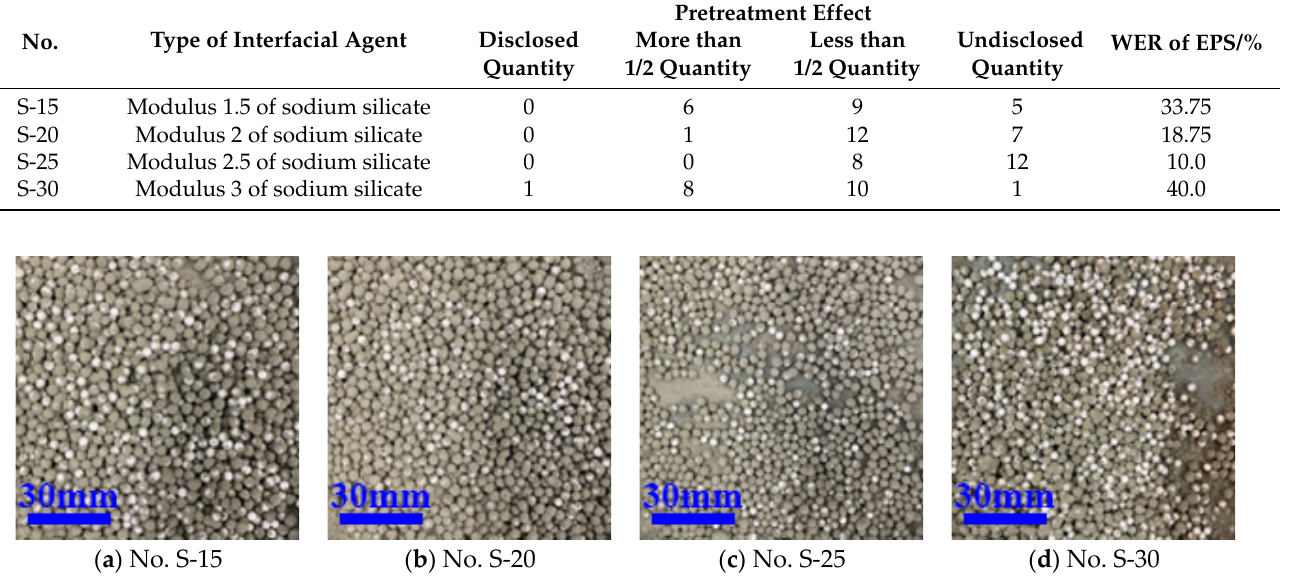
Table 3. Effect of sodium silicate with different moduli on the WER of CSLA.